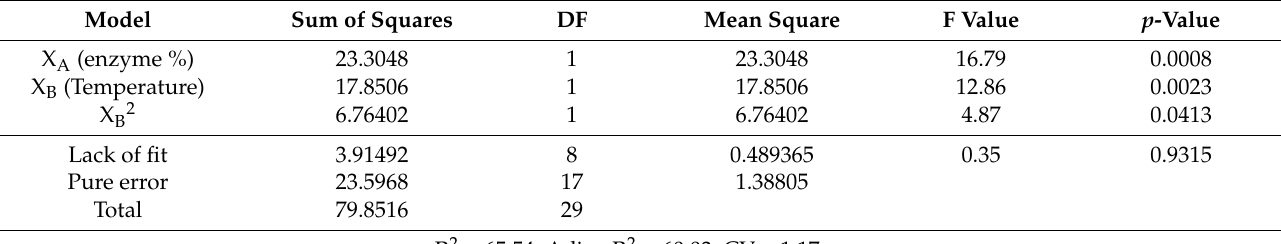
Table 8. Analysis of variance (ANOVA) for protein % obtained for the corolase Box-Behken design. Model